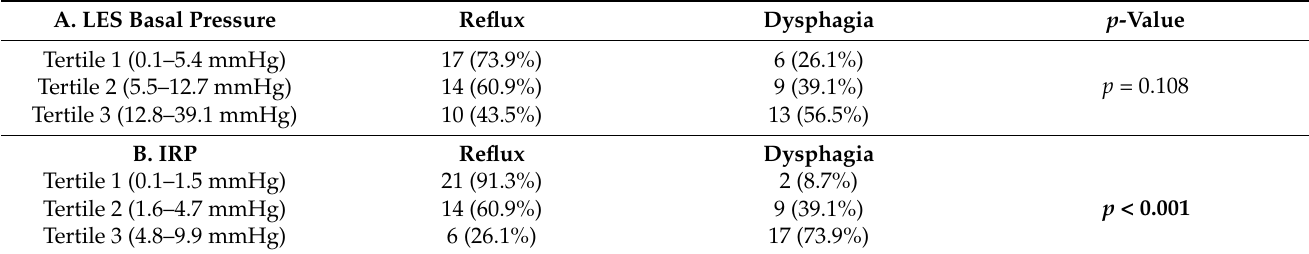
Table 2. Prevalence of Absent Contractility Phenotypes according to HRM Metrics.